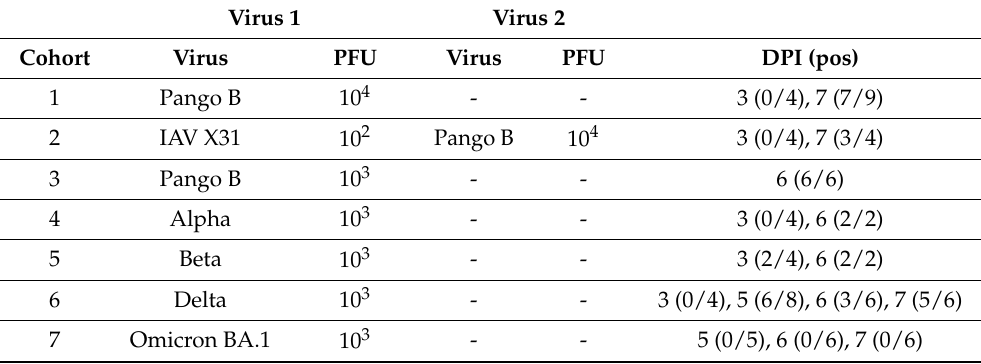
Table 1. Study cohorts. All viruses, unless otherwise stated, are SARS-CoV-2 strains. Animal numbers differ, as for some cohorts, mice originated from several experiments. For SARS-CoV-2 Alpha and Beta, only a few animals were examined to determine whether the strain can also spread to the